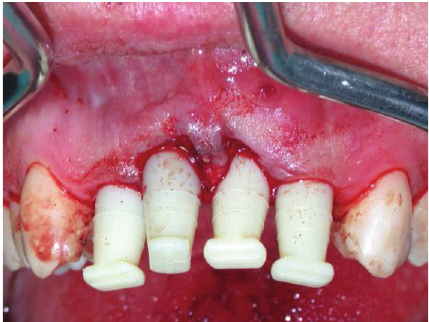
Figure 8: Preformed shouldered abutments with polycarbonate snap-on sleeves.